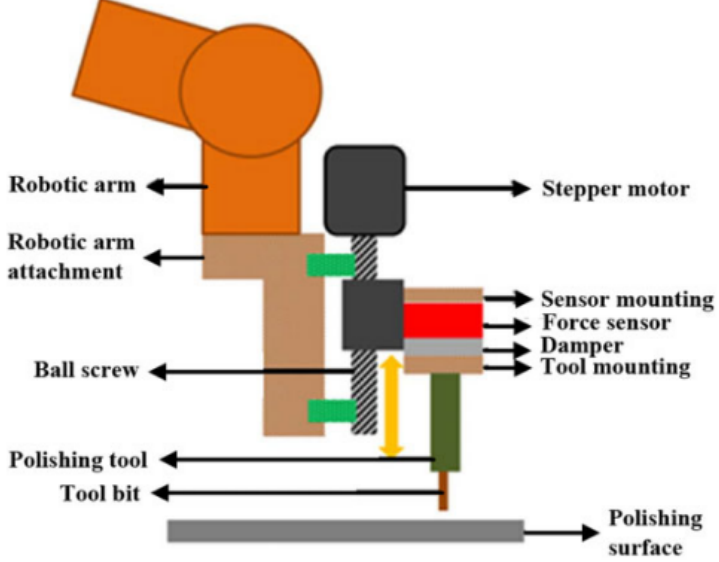
Figure 2. Pot handle polishing mechanism (source: adapted from